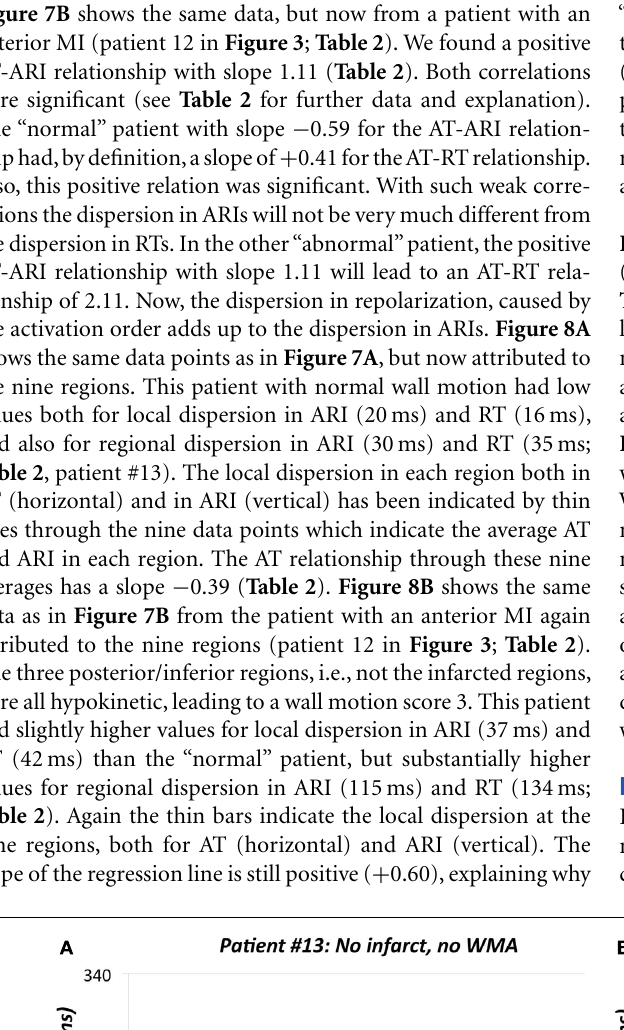
FIGURE 8 | (A) Activation time vs. activation-recovery intervals in the nine regions of patient #13 (see also Figure 3 ; Table 2 ). Y =− 0.39 X + 224; r =− 0.256, ns.Thin lines indicate dispersion in activation times and activation-recovery intervals in each of the nine regions. (B) Activation time vs. activation-recovery intervals in the nine regions of patient #12 (see also Figure 3 ; Table 2 ). Y = 0.60 X + 211; r = 0.168, ns.Thin lines indicate